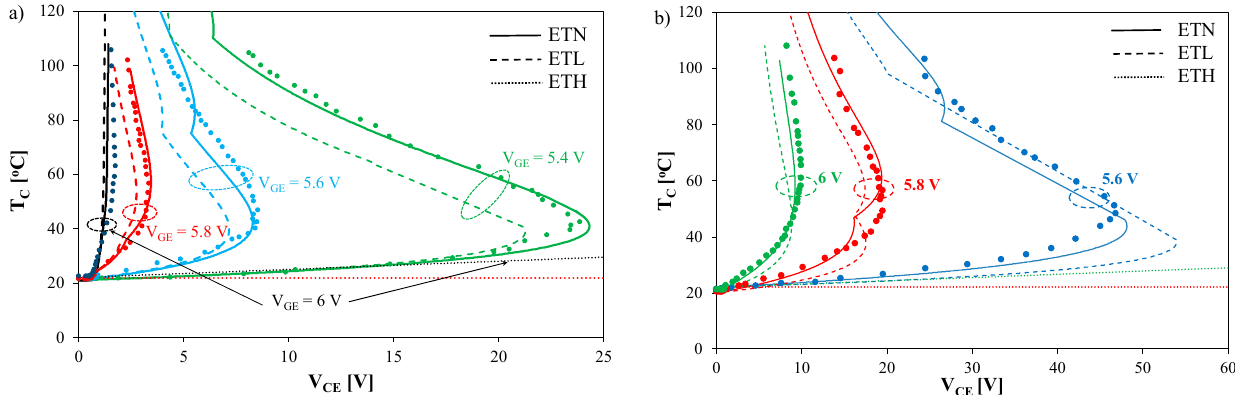
Figure 7. Computed and measured dependences of the case temperature on output voltage at weak steering for the transistor operating without any heat-sink ( a ) and situated on the heat-sink ( b ).